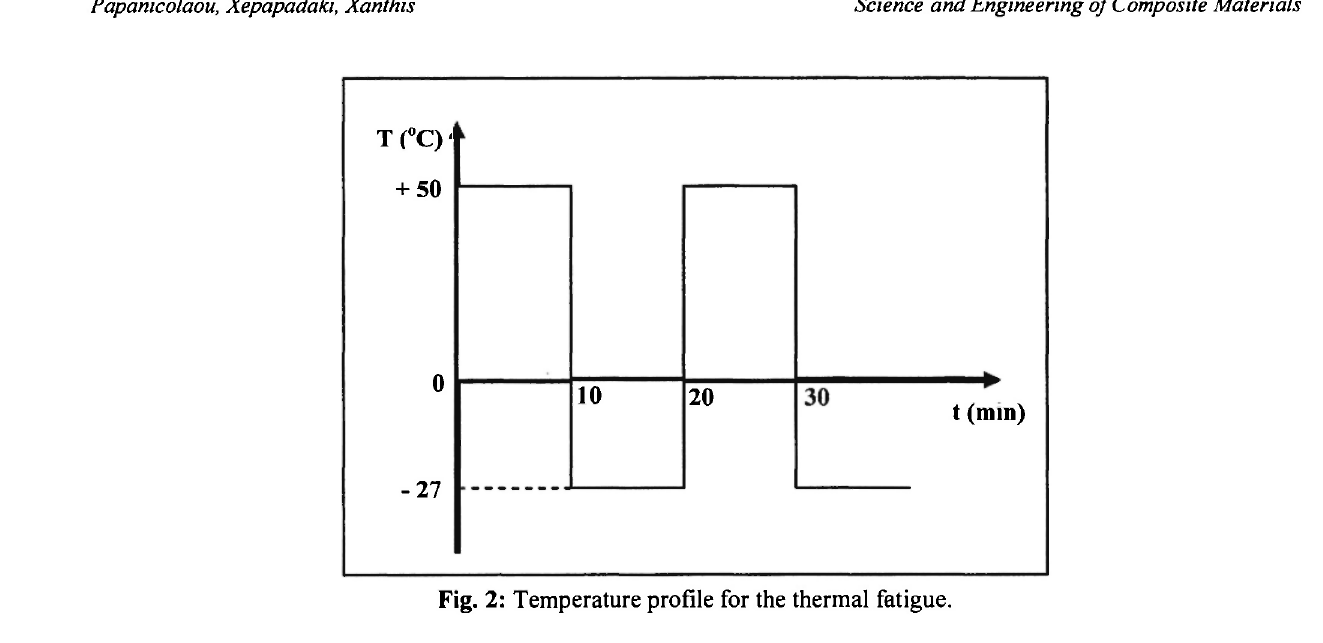
Fig. 2: Temperature profile for the thermal